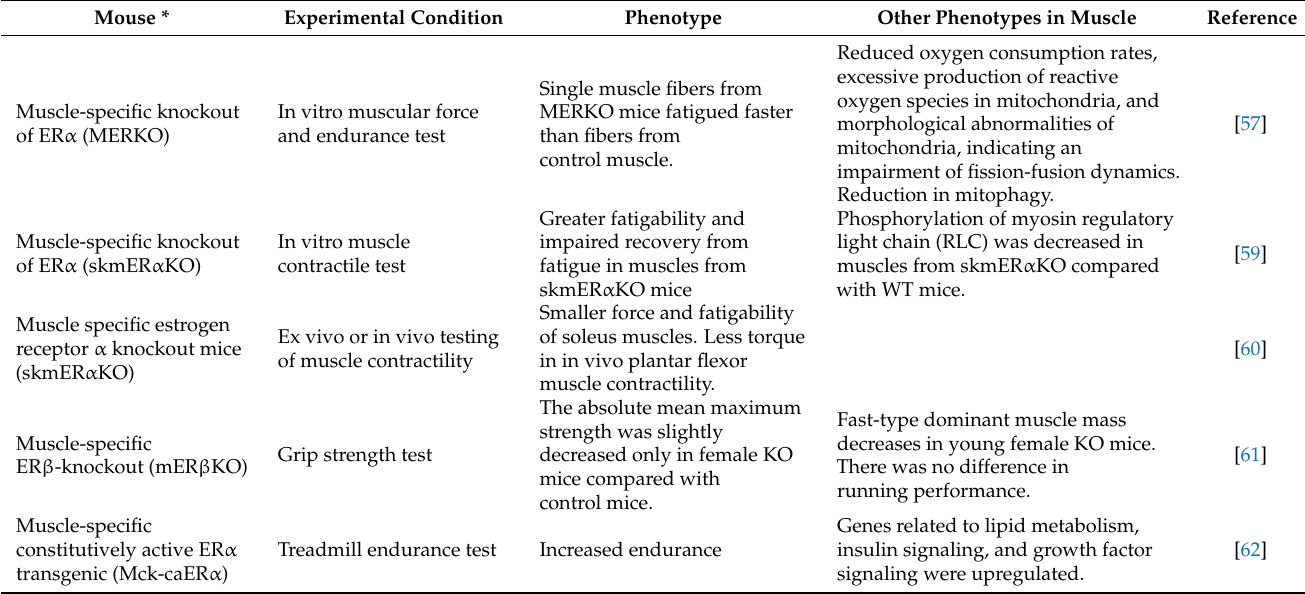
Table 2. Phenotypes of transgenic or knockout mice for ERs on muscle